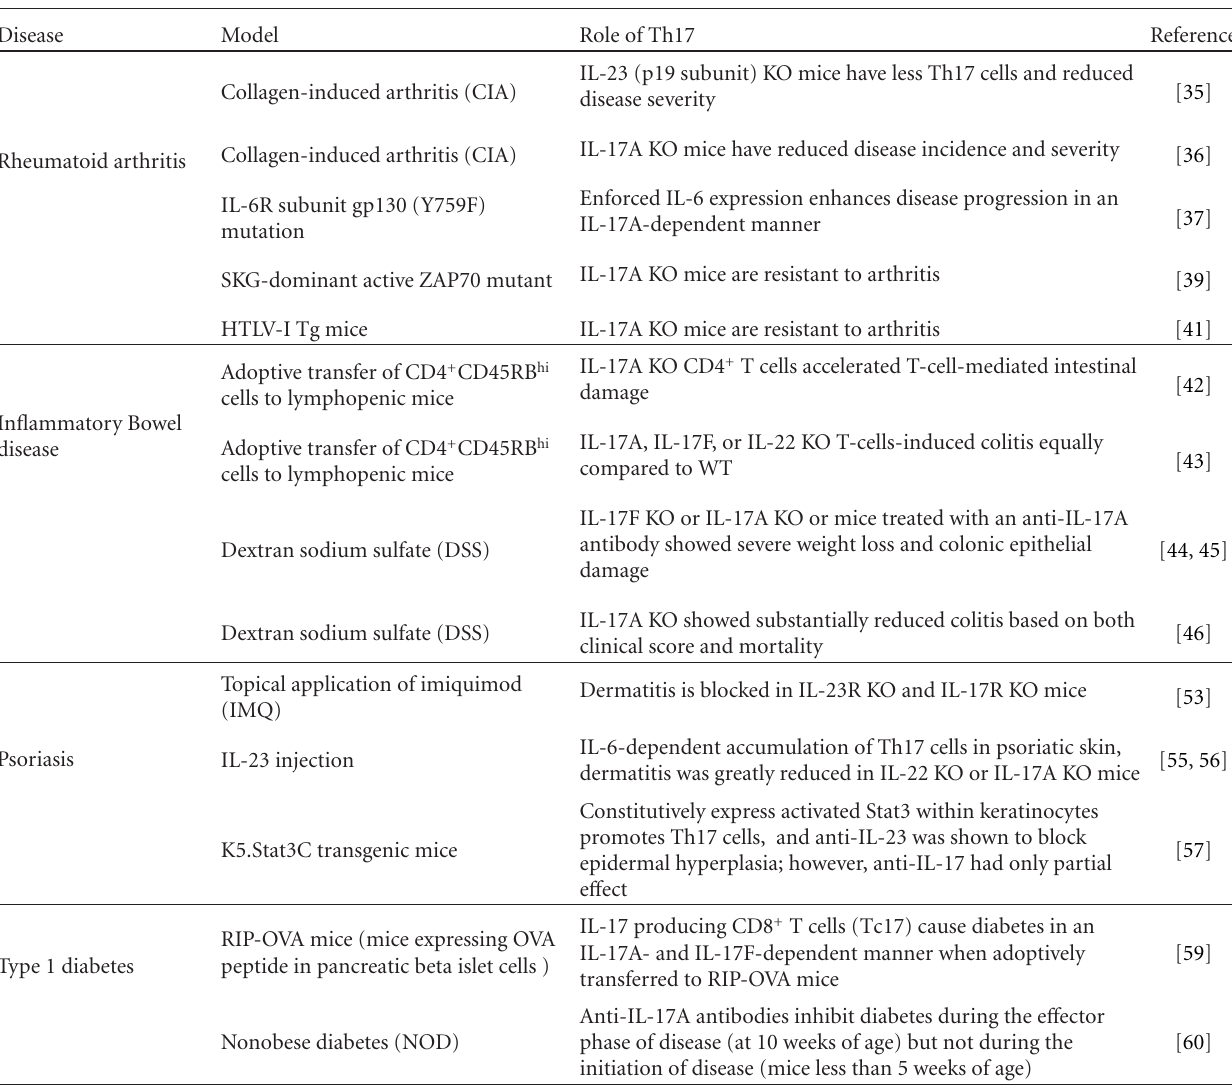
Table 1: Preclinical mouse models showing a role for Th17 cells and the IL-17 pathway in autoimmunity.